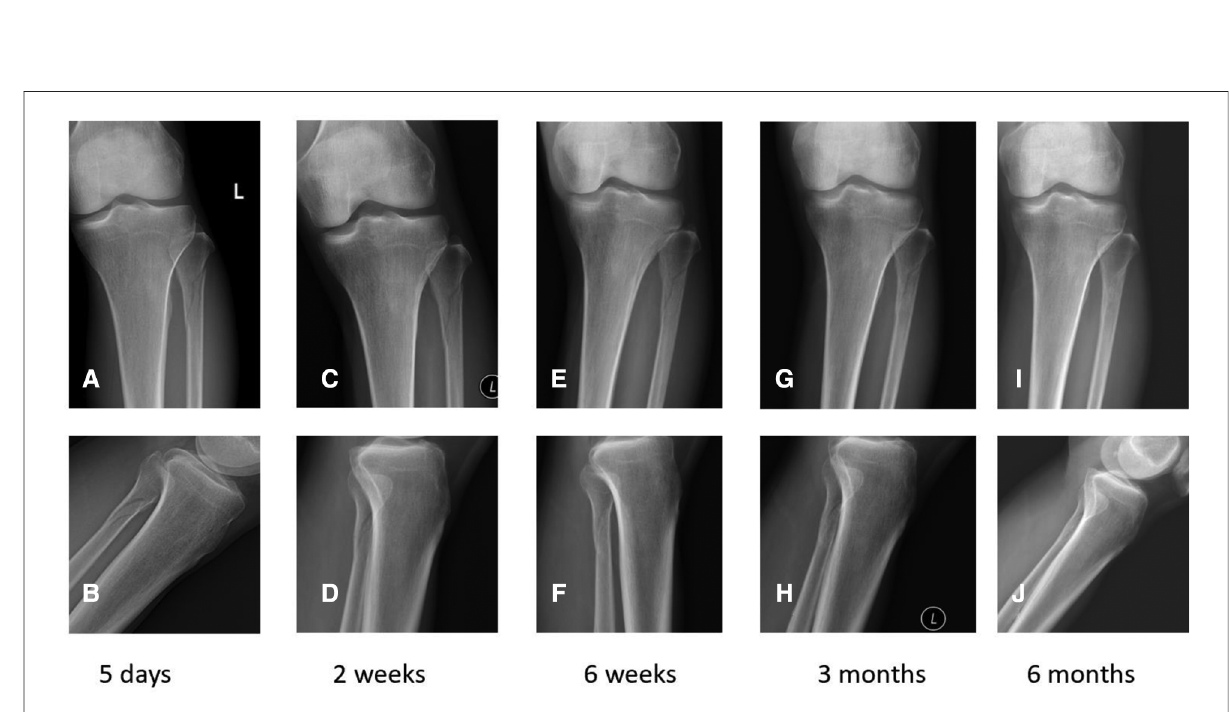
FIGURE 4 Frontal ( A, C, E, G, I ) and lateral ( B, D, F, H, J ) view CT images of the proximal tibia (5 days, 2 weeks, 6 weeks, 3 months, and 6 months after the